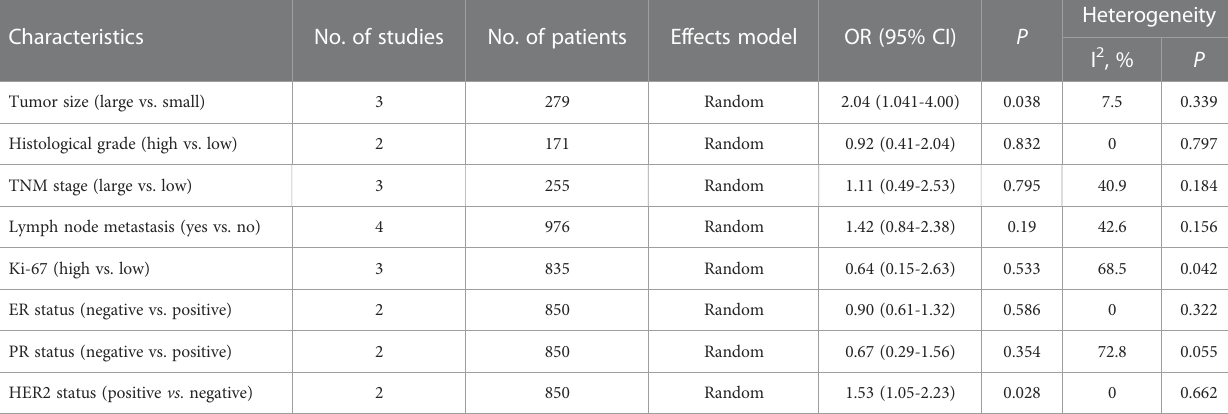
TABLE 3 Correlations of FASN and clinicopathological characteristics in patients with breast cancer.